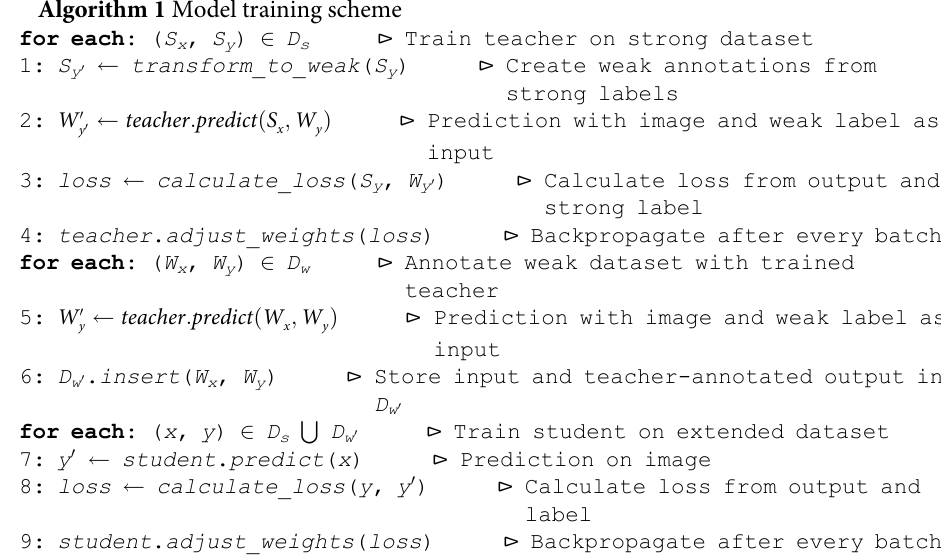
Algorithm 1 Model training